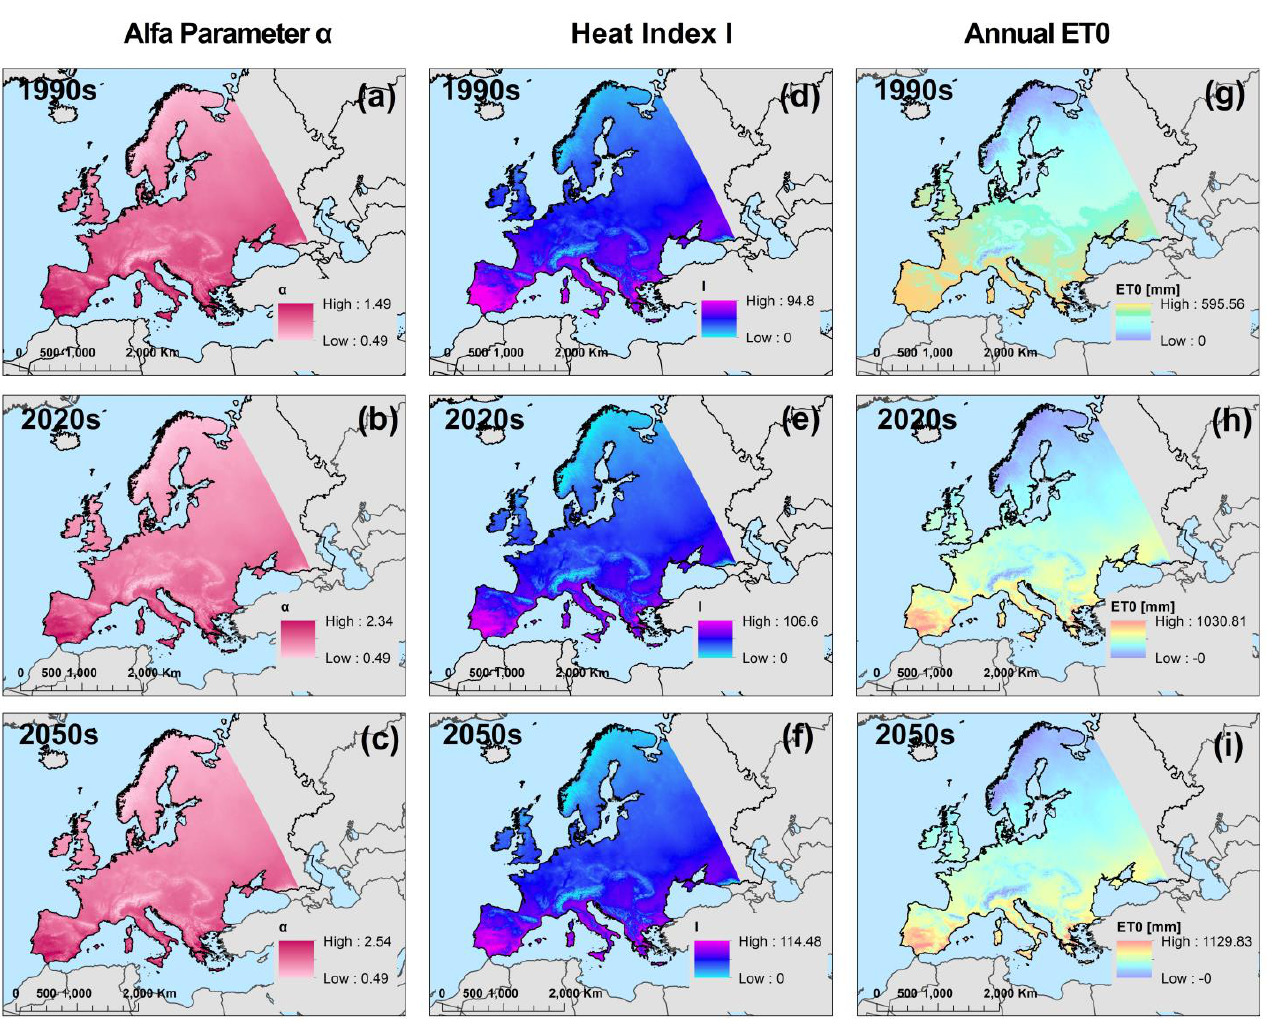
Figure 3. Spatial distribution of Alfa parameter ( α ), heat index (I), and annual potential evapotranspiration (ET0) in Europe. ( a ) Alfa parameter α in 1990s. ( b ) Alfa parameter α in 2020s. ( c ) Alfa parameter α in 2050s. ( d ) Heat index I in 1990s. ( e ) Heat index I in 2020s. ( f ) Heat index I in 2050s. ( g ) Annual ET0 in 1990s. ( h ) Annual ET0 in 2020s. ( i ) Annual ET0 in 2050s.